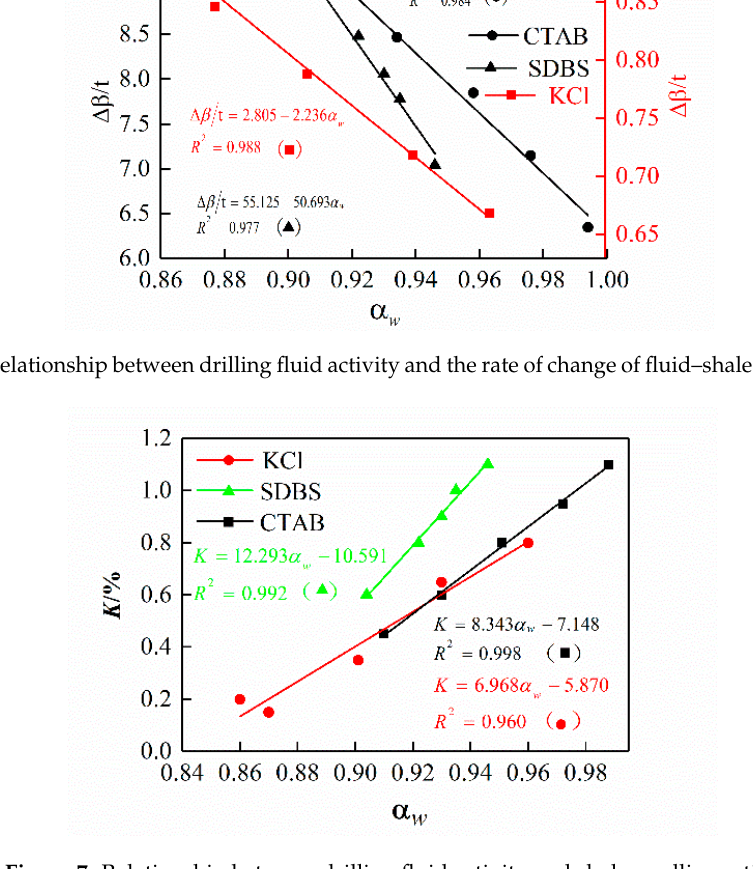
Figure 7. Relationship between drilling fluid activity and shale swelling Figure 6. Relationship between drilling fluid activity and shale swelling ratio.